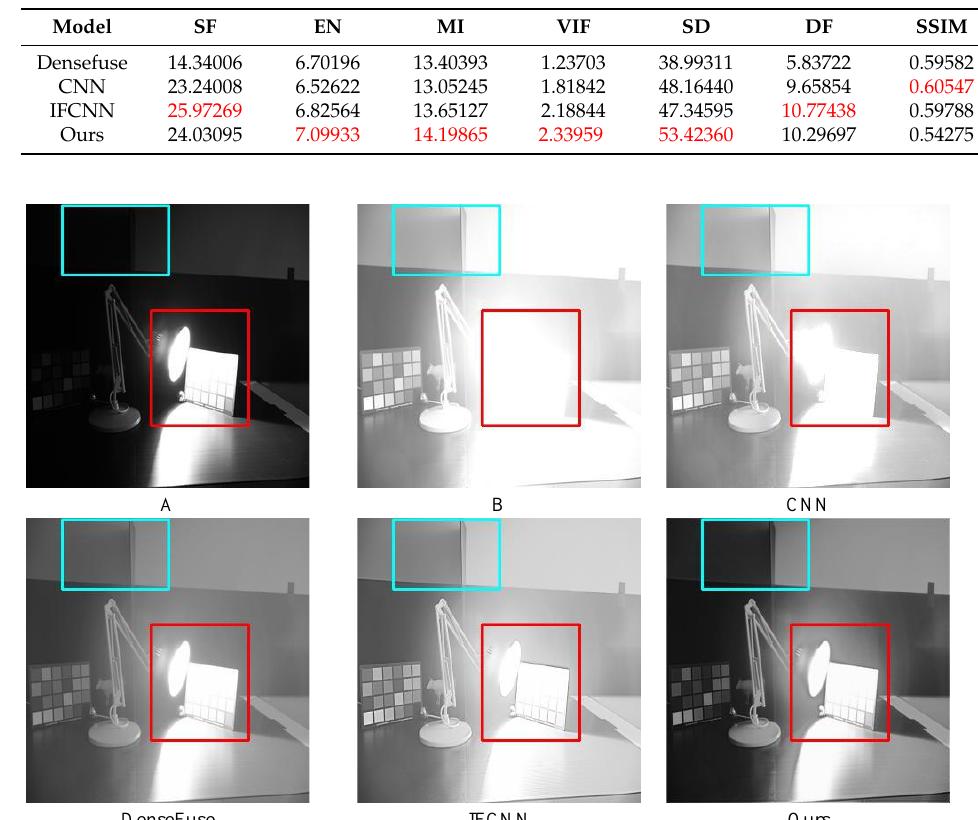
Table 5. The Result of Exposure Datasets.